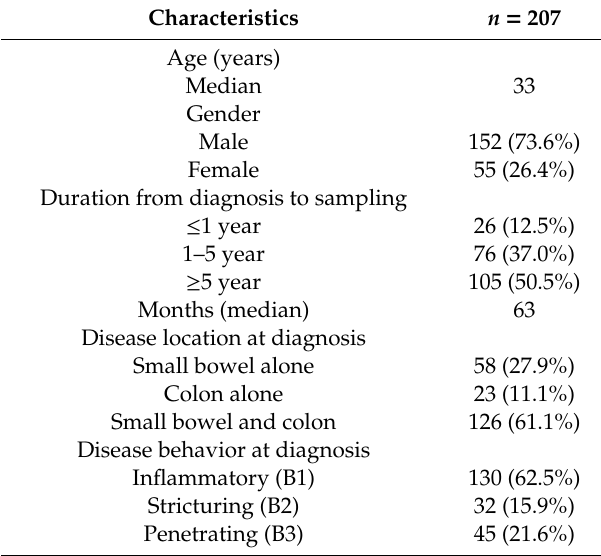
Table 1. Basic characteristics of patients with CD in this